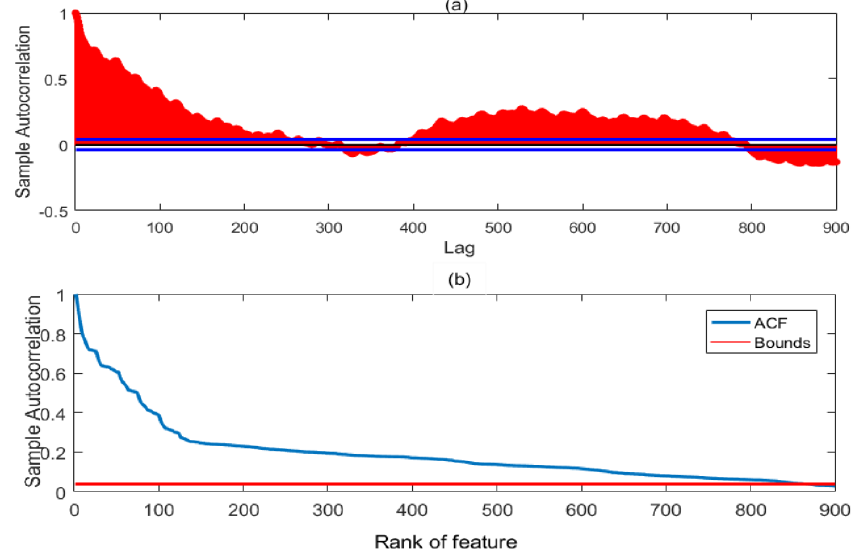
Figure 6. ACF of time lag variables and ranked ACF result in Yibin. ( a ): ACF for each time lag variable;( b ): ranked ACF. Its understanding is similar to Figure